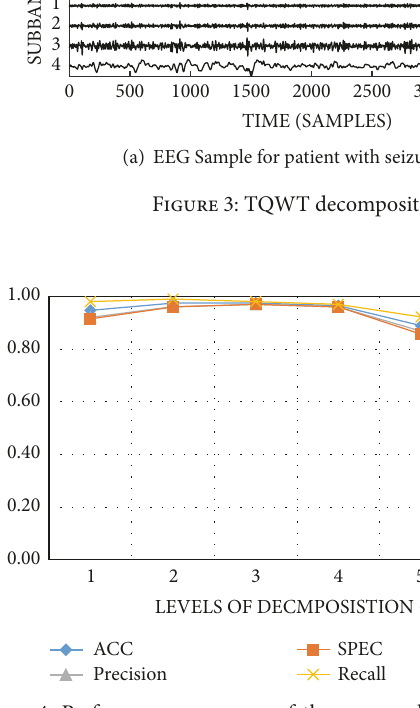
Figure 4: Performance measures of the proposed approach with varied levels of decomposition.